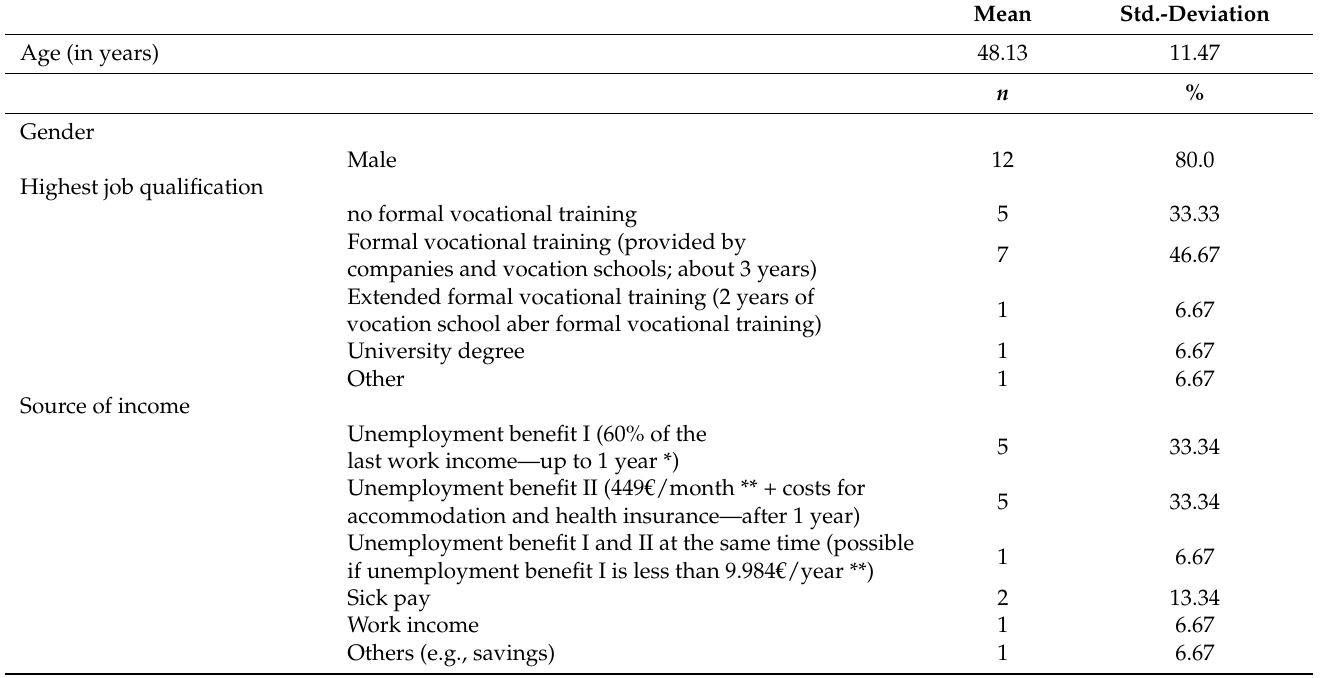
Table 1. Sociodemographic data of